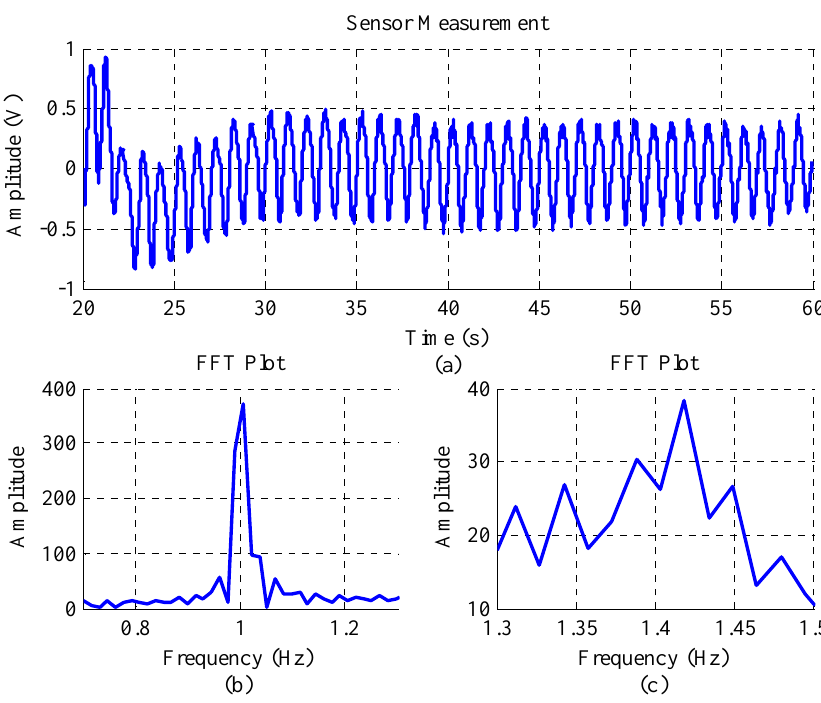
Figure 11. Flexible plate output response and FFT analysis without vibration suppression: ( a ) time response of uncontrolled system output, ( b ) FFT results at 1 Hz, and ( c ) FFT results at resonance frequency.